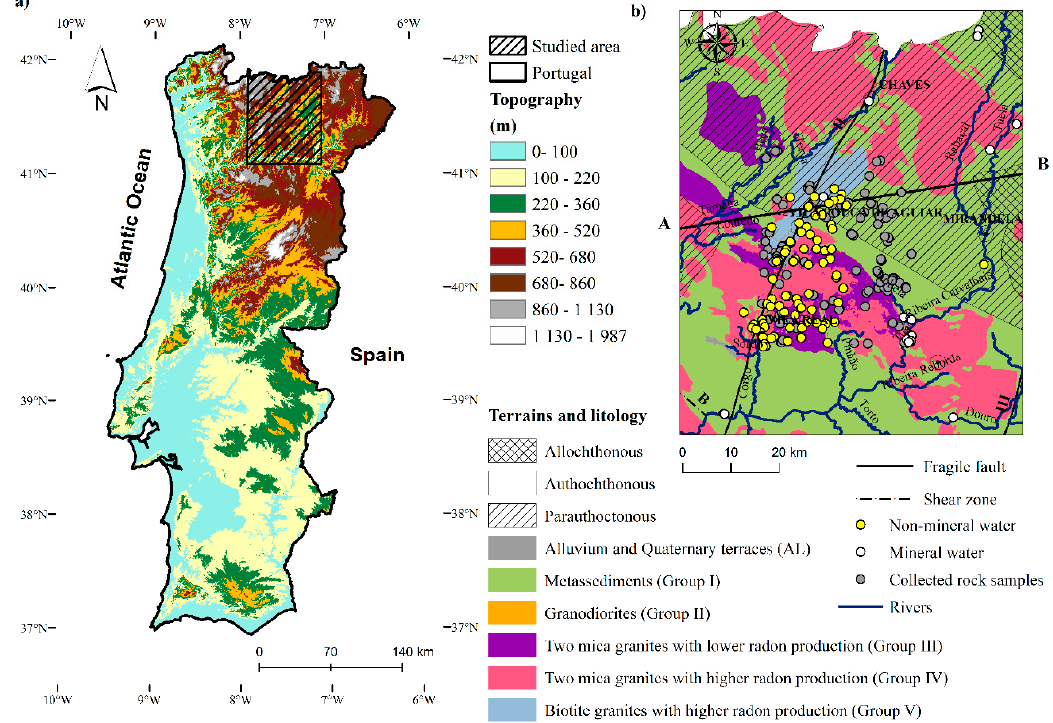
Figure 1. Several hydrogeological, topography and drainage network represented for the studied region: ( a ) digital elevation / drainage network models of studied region; ( b ) simplified geological map of studied area, based on the geological map of Portugal, scale 1: 500,000 and 1:50,000 in the influence